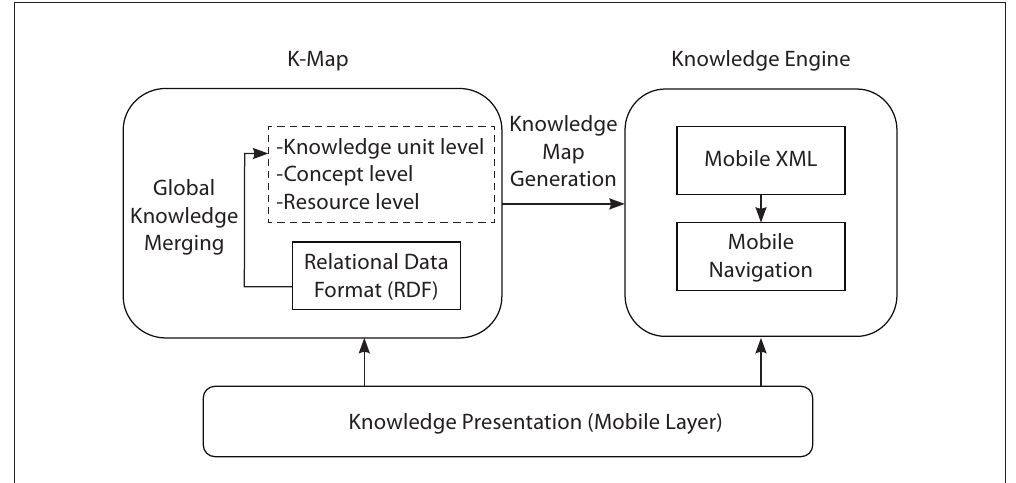
Figure 3 Proposed framework of K-Map